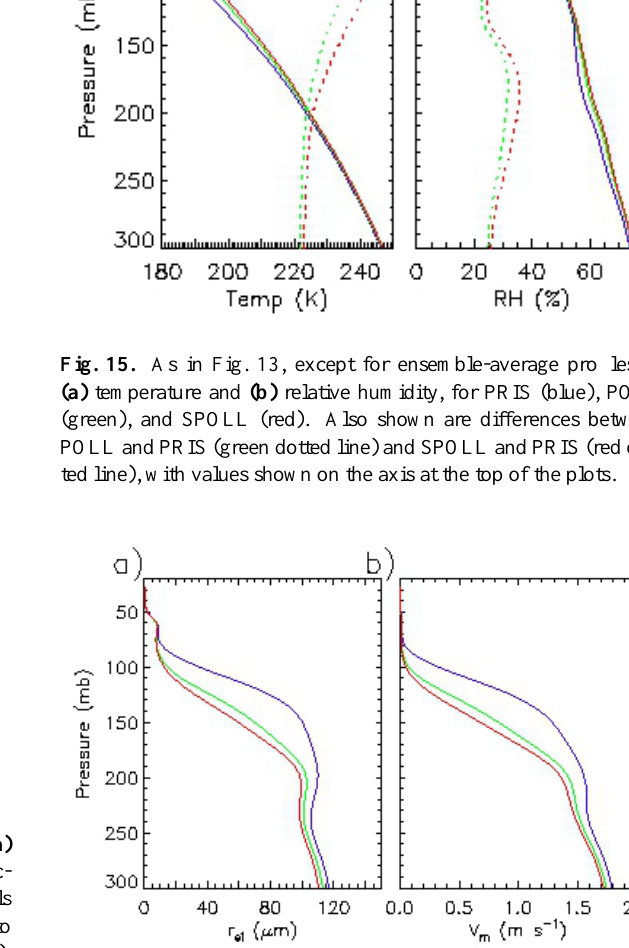
Fig. 16. Vertical profiles of ensemble- and horizontally-averaged mass-weighted (a) ice effective radius, r ei , and (b) ice particle fallspeed, V m , for PRIS (blue), POLL (green), and SPOLL (red). Presented results are averaged between 12:00UTC 19 January and 12:00UTC 25